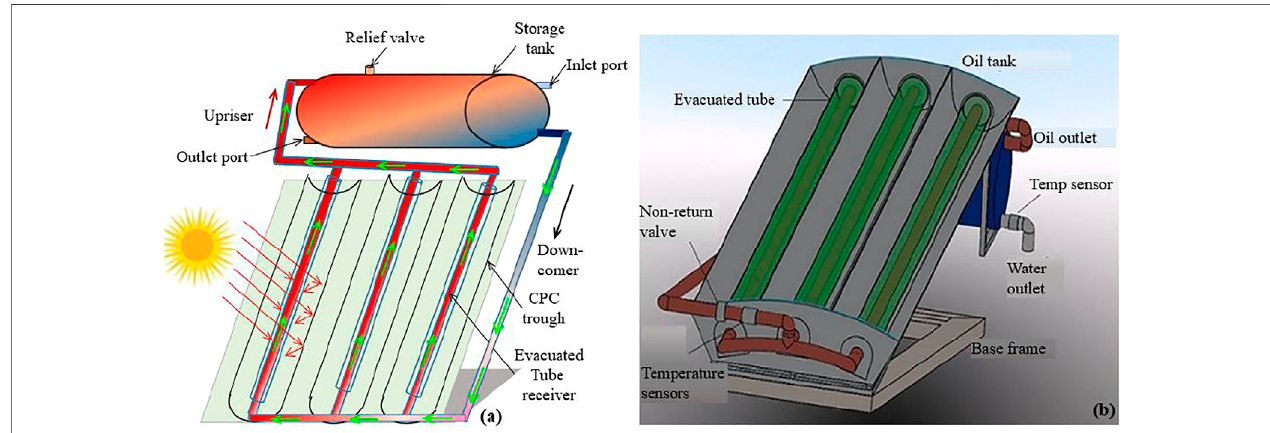
FIGURE 6 | CPC troughs with evacuated tube receivers (A) schematic of the experimental setup, (B) CAD model of the complete test rig.